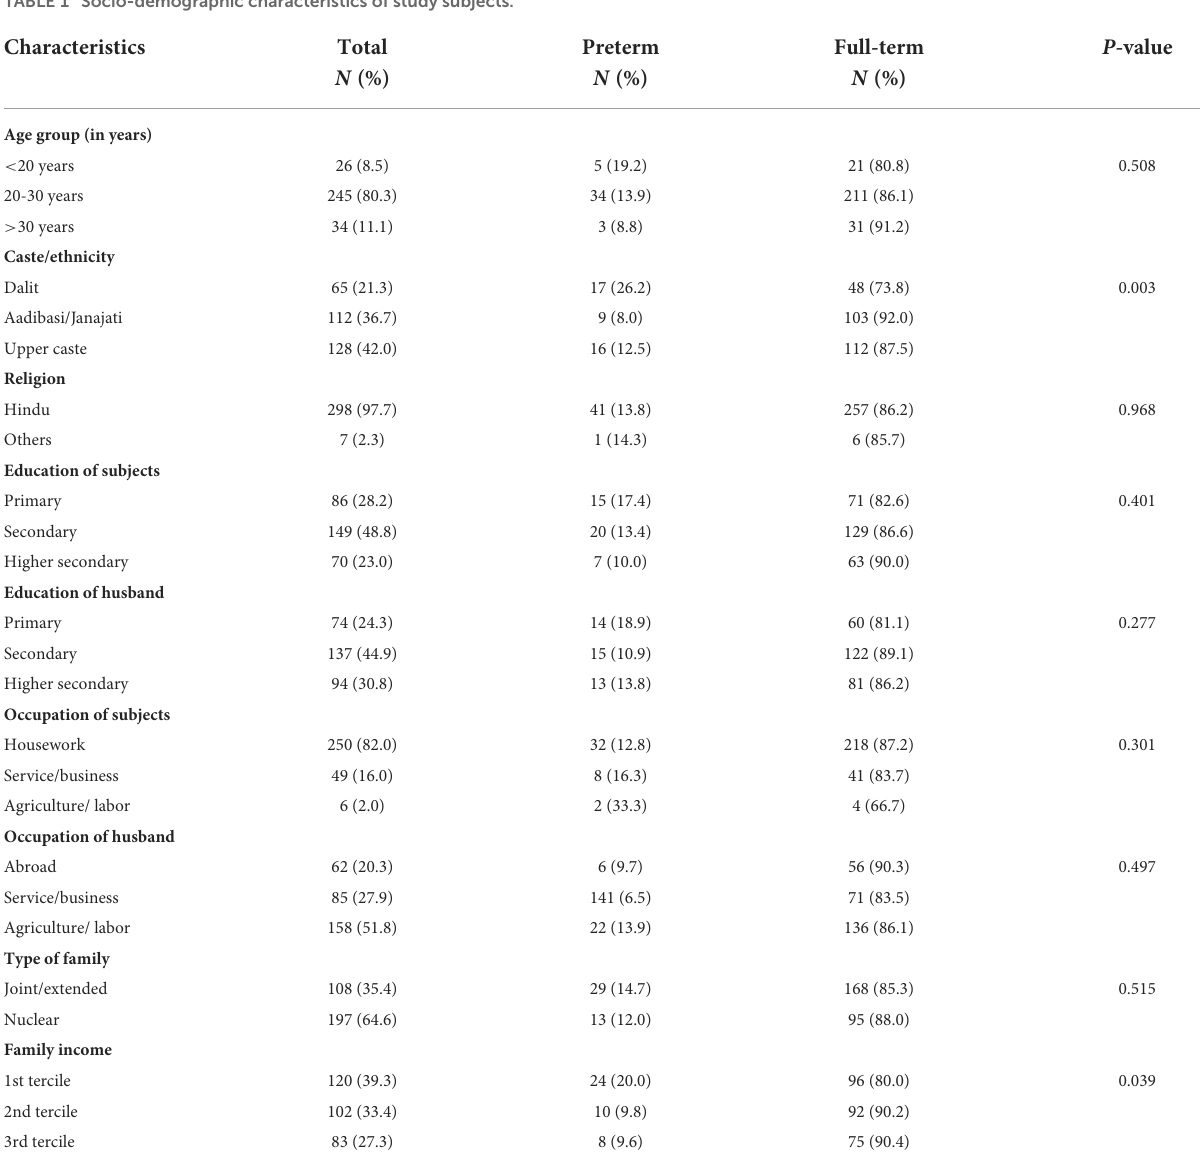
TABLE 1 Socio-demographic characteristics of study